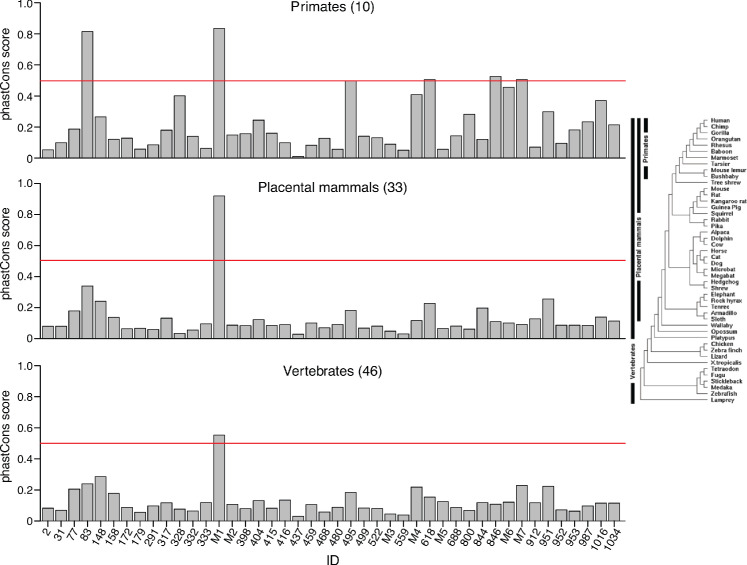
Bar graphs showing phastCons scores for 44 full-length excised introns detected in human plasma.PhastCons scores were calculated for 10 primates, 33 placental mammals, and 46 vertebrates shown in the phylogenetic tree on the right. PhastCons calculates the probability that a nucleotide belongs to a conserved sequence with the score for the peak calculated by averaging the score for each nucleotide within the peak. Scores can range from 0 to 1, with 1 being the most conserved, and 0 being the least conserved. The red line indicates a phastCons score of 0.5. M1-7 are full-length excised intron RNAs that encode non-high confidence miRNA: M1, mir-1225; M2, mir-4721; M3, mir-7108; M4, AC068946.1; M5, mir-6821; M6, mir-6891; M7, mir-1236.